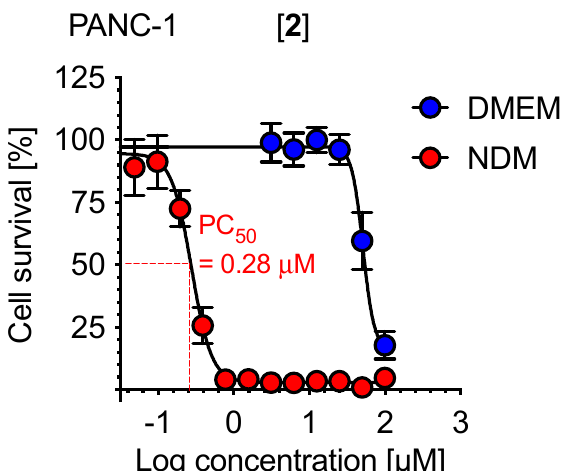
Figure 3. Preferential cytotoxicity activity of myrtucommulone A ( 2 ) against the PANC-1 human pancreatic cancer cell line in nutrient-deprived medium (NDM) and Dulbecco’s modified Eagle’s medium (DMEM).